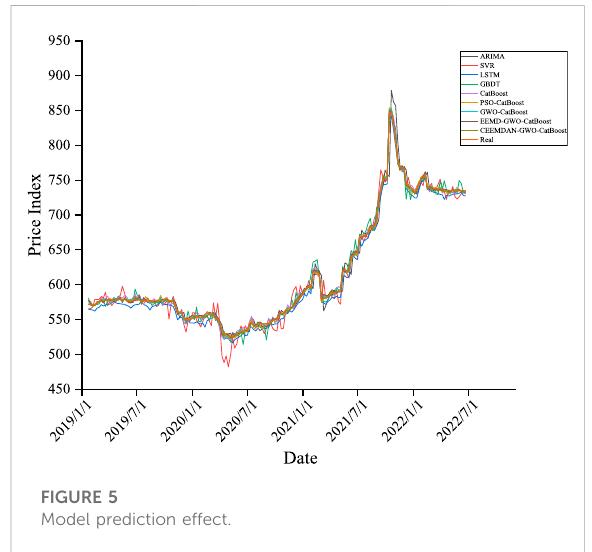
FIGURE 5 Model prediction effect.